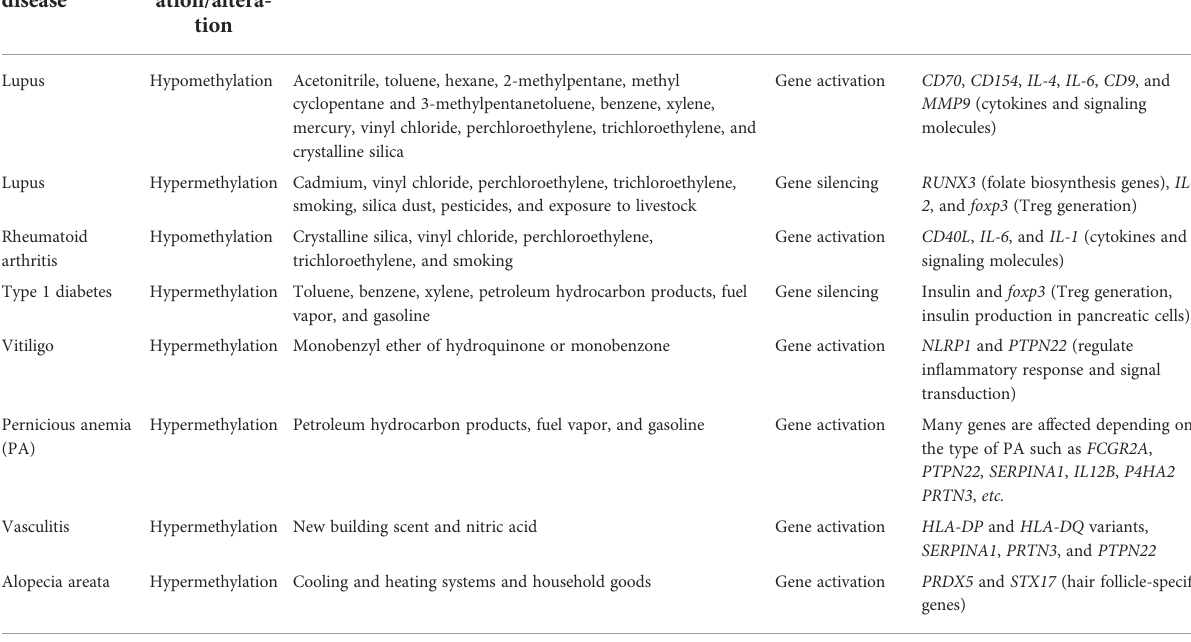
TABLE 3 DNA methylation alterations in autoimmune disease. Autoimmune